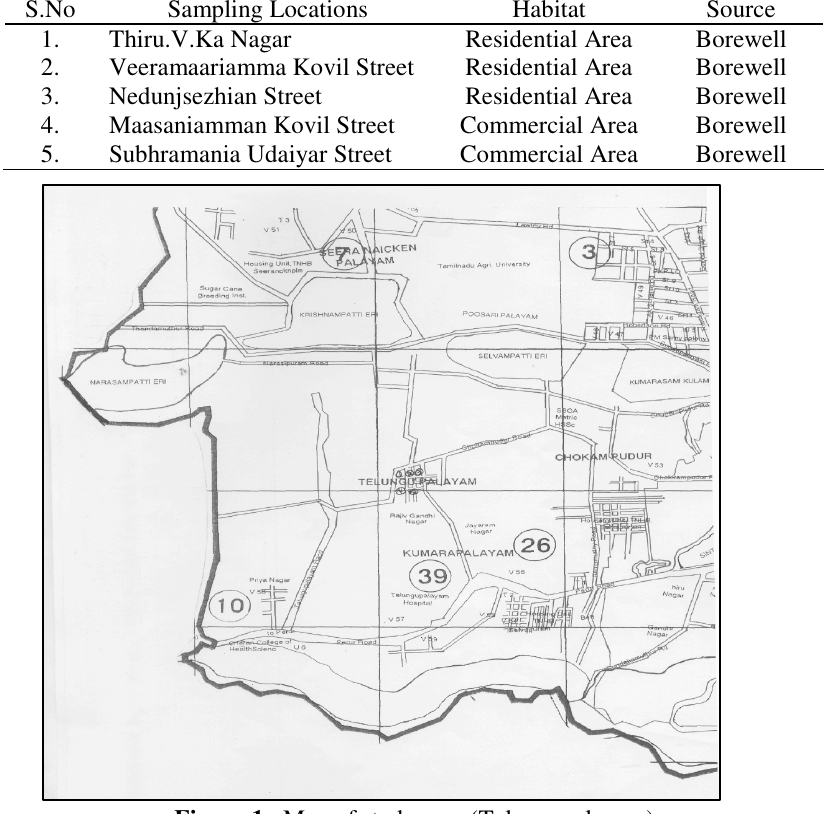
Figure 1. Map of study area